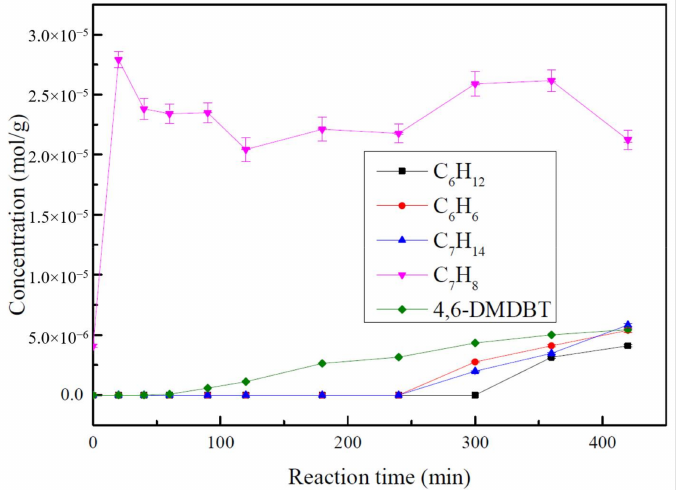
Figure 8. Concentrations of the products with time on stream over CoMo/AZ (reaction conditions: the same as the conditions in Figure